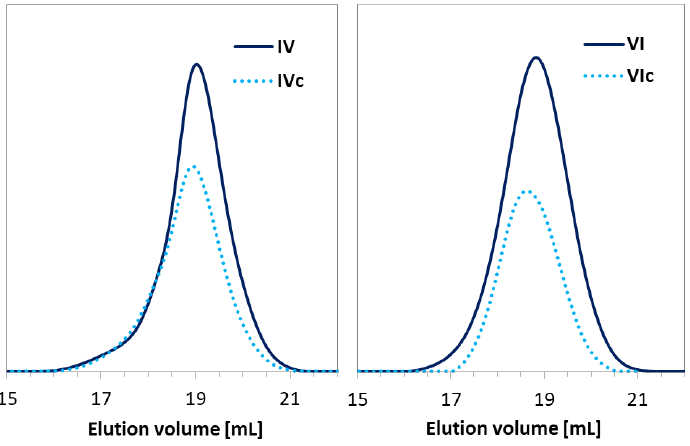
Figure 5. GPC traces for copolymers before (IV, VI) and after “click” reaction (IVc, VIc) .